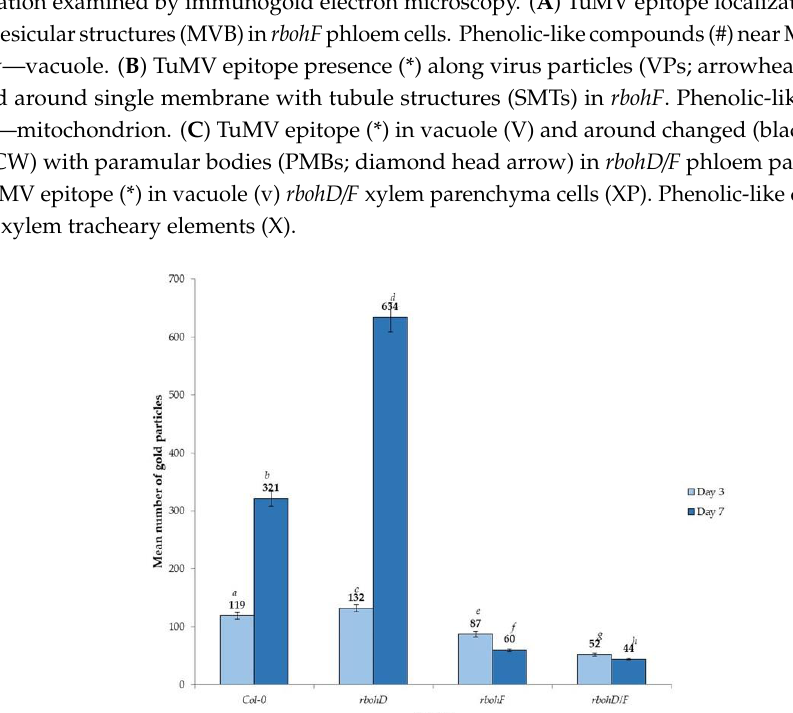
Figure 8. Quantification of gold particles associated with TuMV in Arabidopsis thaliana Col-0, rbohD , rbohF and double rbohD/F mutants at 3 and 7 days after inoculation. Significant differences between classes at p < 0.05 level of significance by ANOVA with post-hoc Tukey HSD were assessed. The statistical significant values are marked by letters above chart